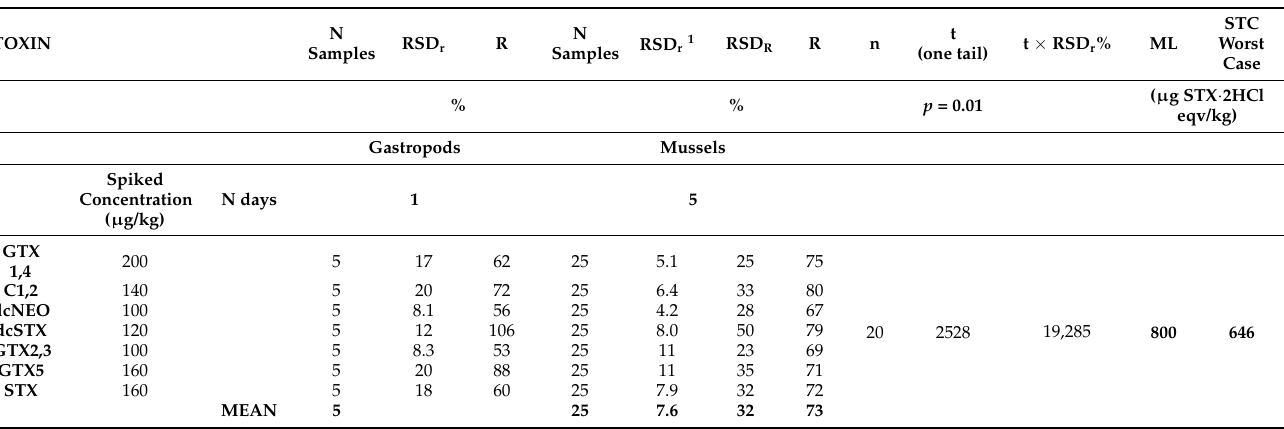
Table 1. Validation study results on mussels and gastropods. Application of Single factor ANOVA (only